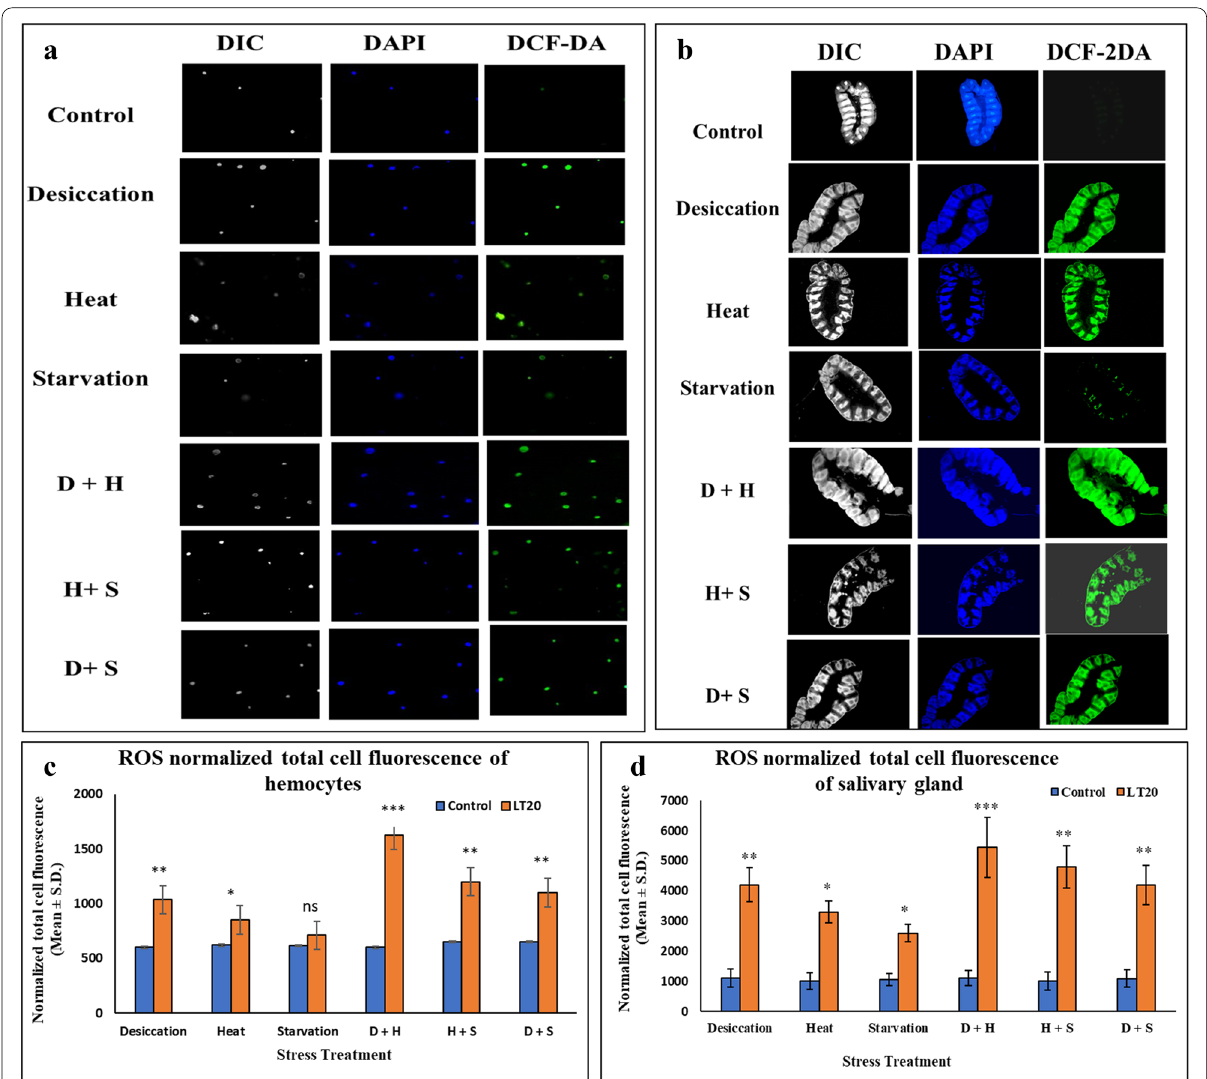
Fig. 3 Cellular level visualization of reactive oxygen species (ROS): Fluorescence microscopic images of fluorescent dye 2 ′ ,7 ′ -dicholorodihydrofluorescein diacetate (DCF-2DA), 4 ′ ,6-diamidino-2-phenylindole (DAPI) and differential interference contrast (DIC) of hemocytes and salivary glands of C. ramosus exposed to desiccation, heat, starvation, D control a hemocytes (400X) b salivary glands (100X) to visualize ROS. Normalized cell fluorescence intensity of c hemocytes d salivary gland of C. ramosus to quantify reactive nitrogen species. ***P < 0.001; **P < 0.01; *P < 0.05: ns-